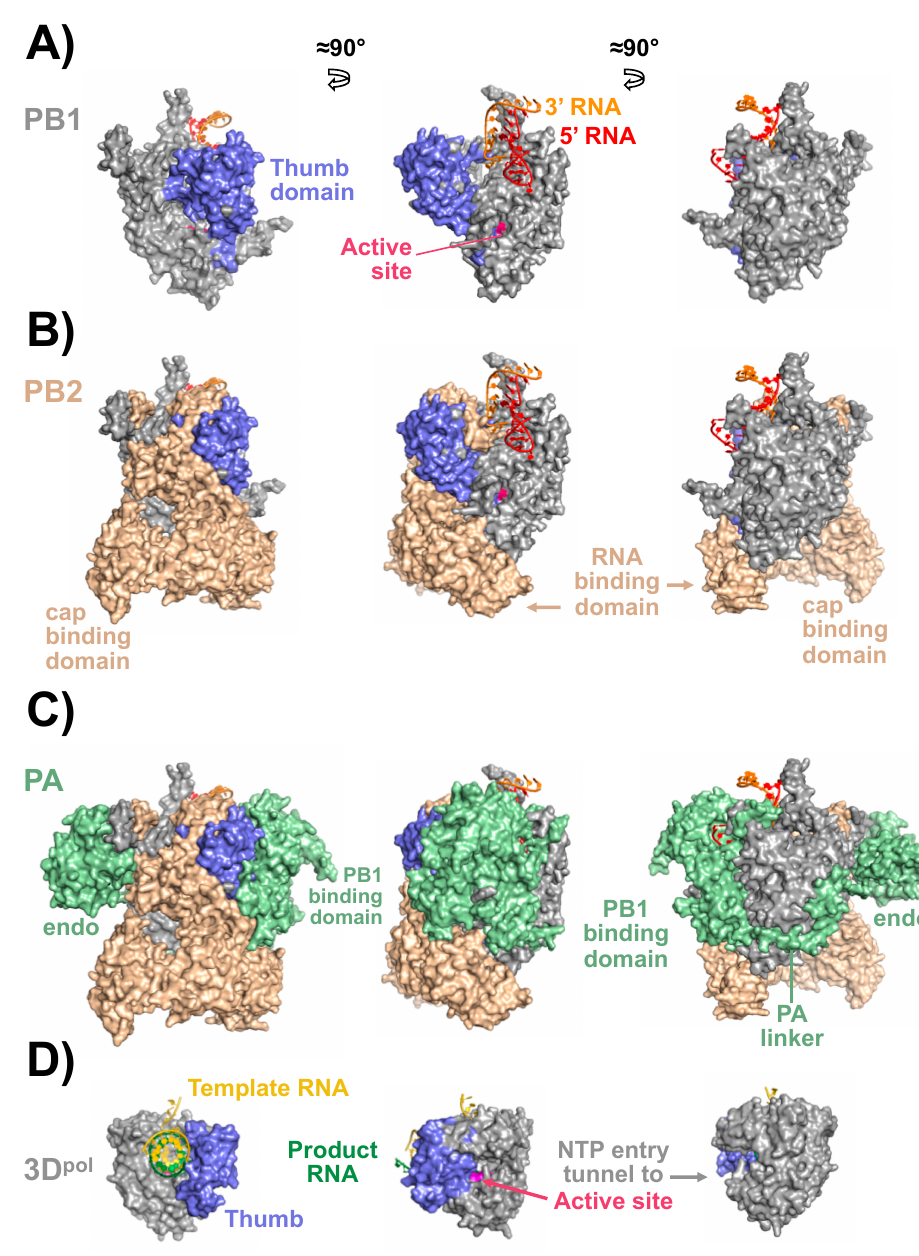
Figure 2. Structure of the IAV polymerase complex. The IAV polymerase complex structure is shown in three different views (left to right) rotated by ≈ 90° between each, and the same coloring is retained in all images (PDB code 4WSB). A dynamic version of this figure where the molecules can be rotated in real time is available online as Figure S1. Panel A shows the PB1 RdRp subunit in grey with its thumb domain colored blue, the active site within conserved motif C shown in magenta, and the 5 ′ and 3 ′ RNAs shown in red and orange, respectively. Panel B adds the PB2 subunit in wheat color with its two major domains (RNA and cap binding) indicated. PB2 associates with a large surface on PB1, effectively forming one large globular structure from which the PB2 cap binding and RNA binding domains protrude. Panel C illustrates how the RdRp PA subunit wraps around the PB2-PB1 complex, with its N-terminal endonuclease domain on one side of the complex, the PB1 binding domain forming the major exterior surface of the complex on the other side, and the linker sequence being extended across the PB1 surface. Panel D shows the to-scale structure of the poliovirus polymerase elongation complex, among the smallest single subunit viral polymerases, for size comparison and in the same orientations (PDB code 3OL6).